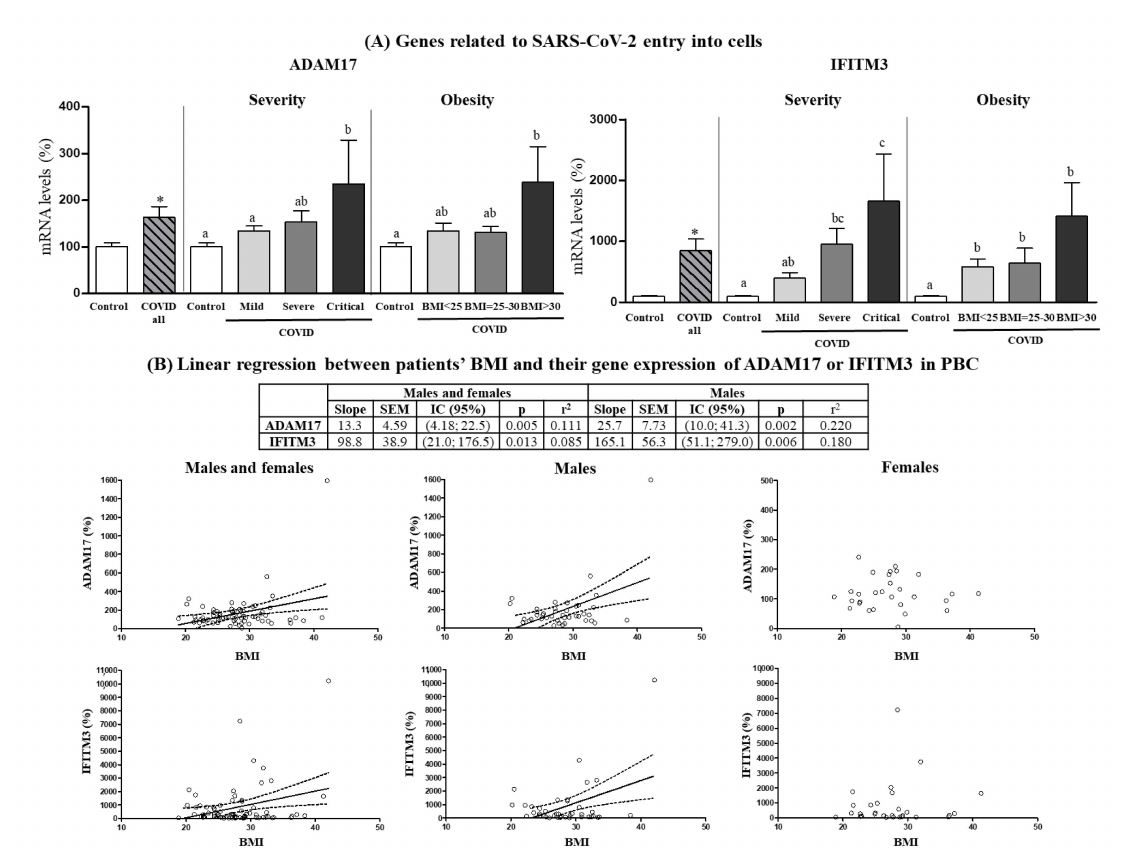
Figure 2. ( A ) Expression levels in PBCs of the indicated genes related to SARS-CoV-2 entry into cells in control subjects and COVID-19 patients (all) and separated according to COVID-19 severity and obesity. ( B ) Linear regression between patients’ BMI and their gene expression in PBCs of ADAM17 or IFITM3 . mRNA levels were measured by real-time qPCR and expressed as a percentage of the value of Controls (males and females). Data are expressed as the mean ± SEM. Statistics: differences between stratified groups were analyzed by one-way ANOVA followed by least significant difference (LSD) post-hoc test, a (cid:54) = b (cid:54) = c ( p < 0.05). Student’s t test was used for single comparisons: *, COVID all vs